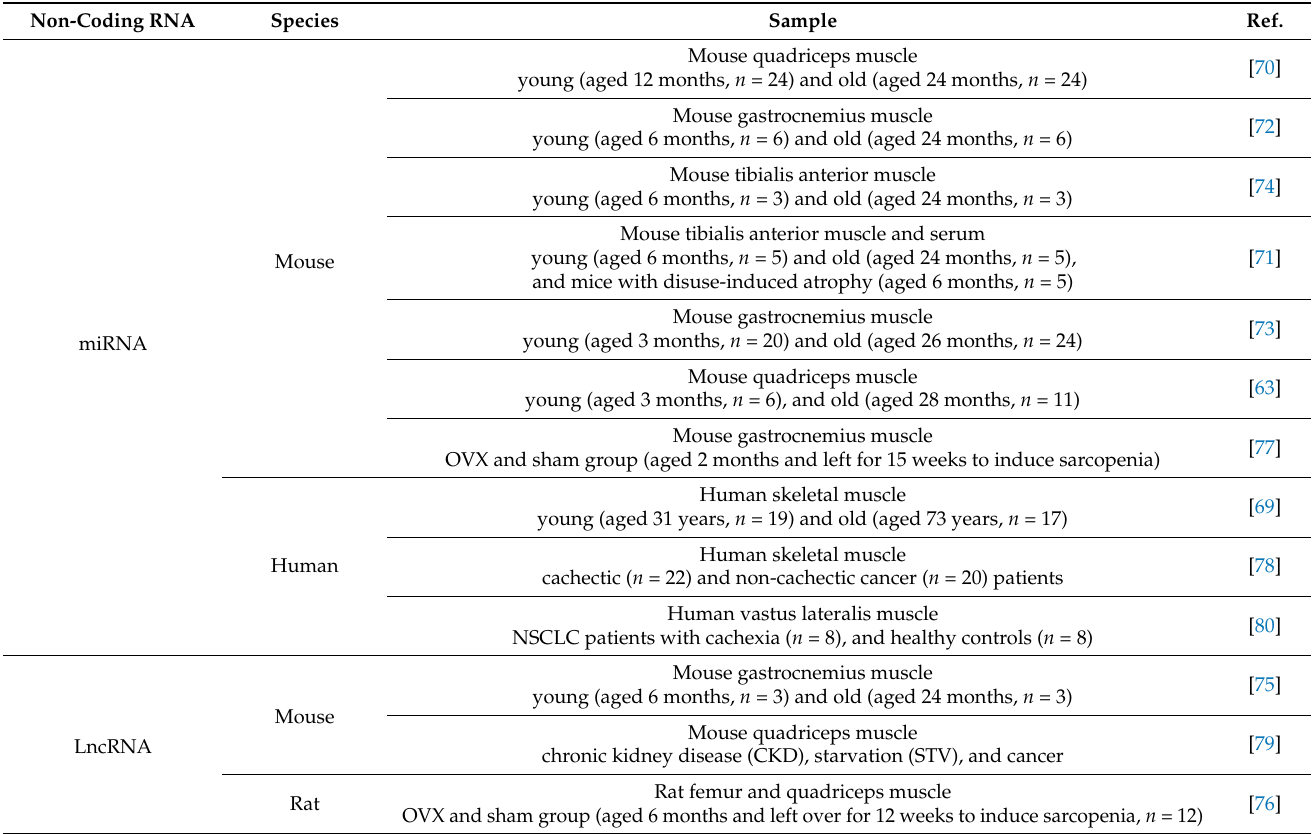
Table 1. Studies profiling non-coding RNAs in sarcopenia. Non-Coding